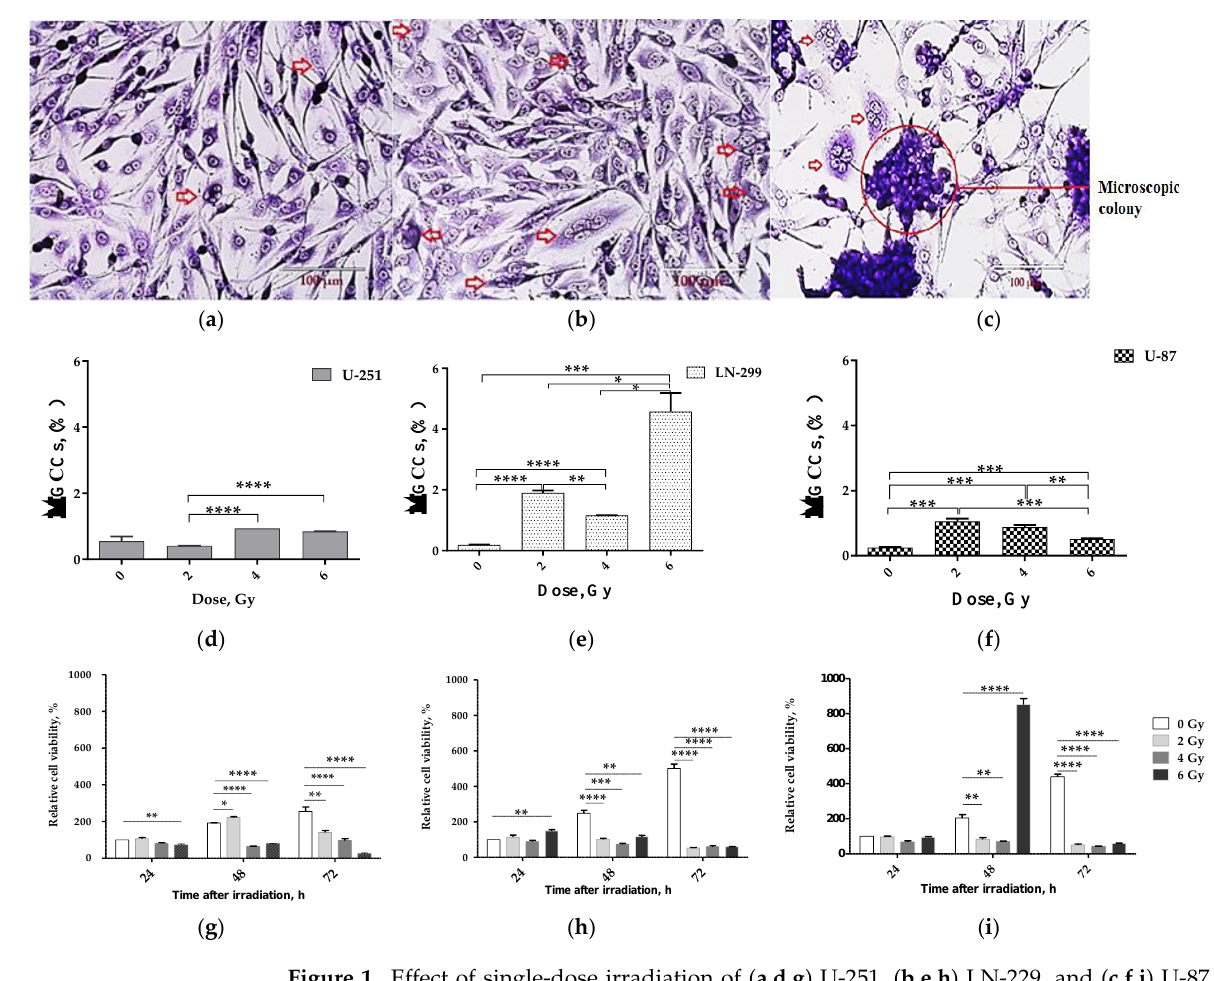
one in U-251 cells. This suggests that transactivation is functional in wild-type or mutated p53 and its driven pathway is necessary and sufficient for PGCC/MGCC formation.